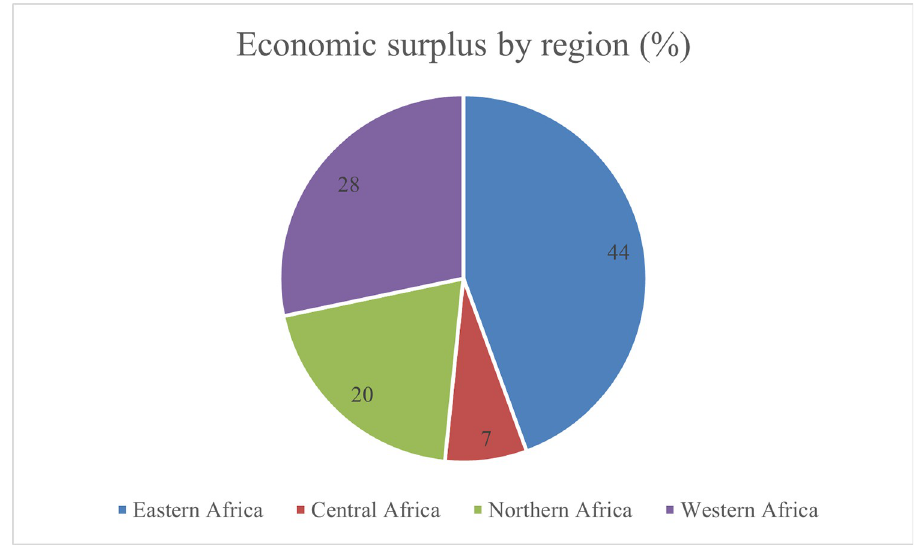
Fig 3. Share of economic surplus by